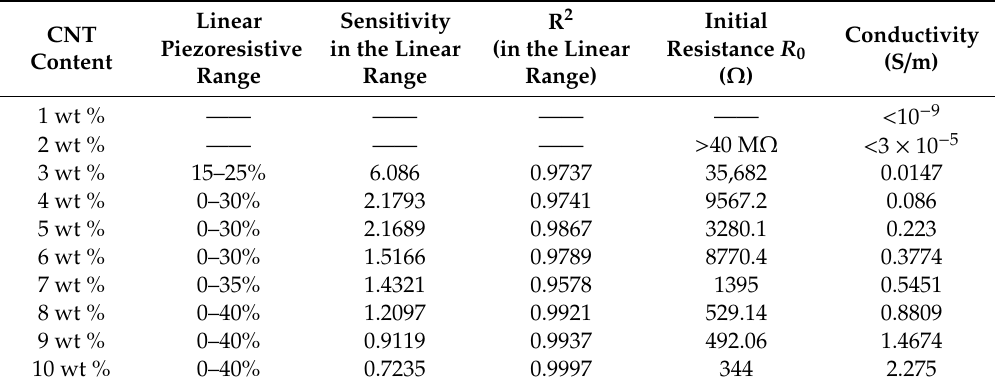
Table 2. Pressure-sensitive properties of CNT-PDMS composites: